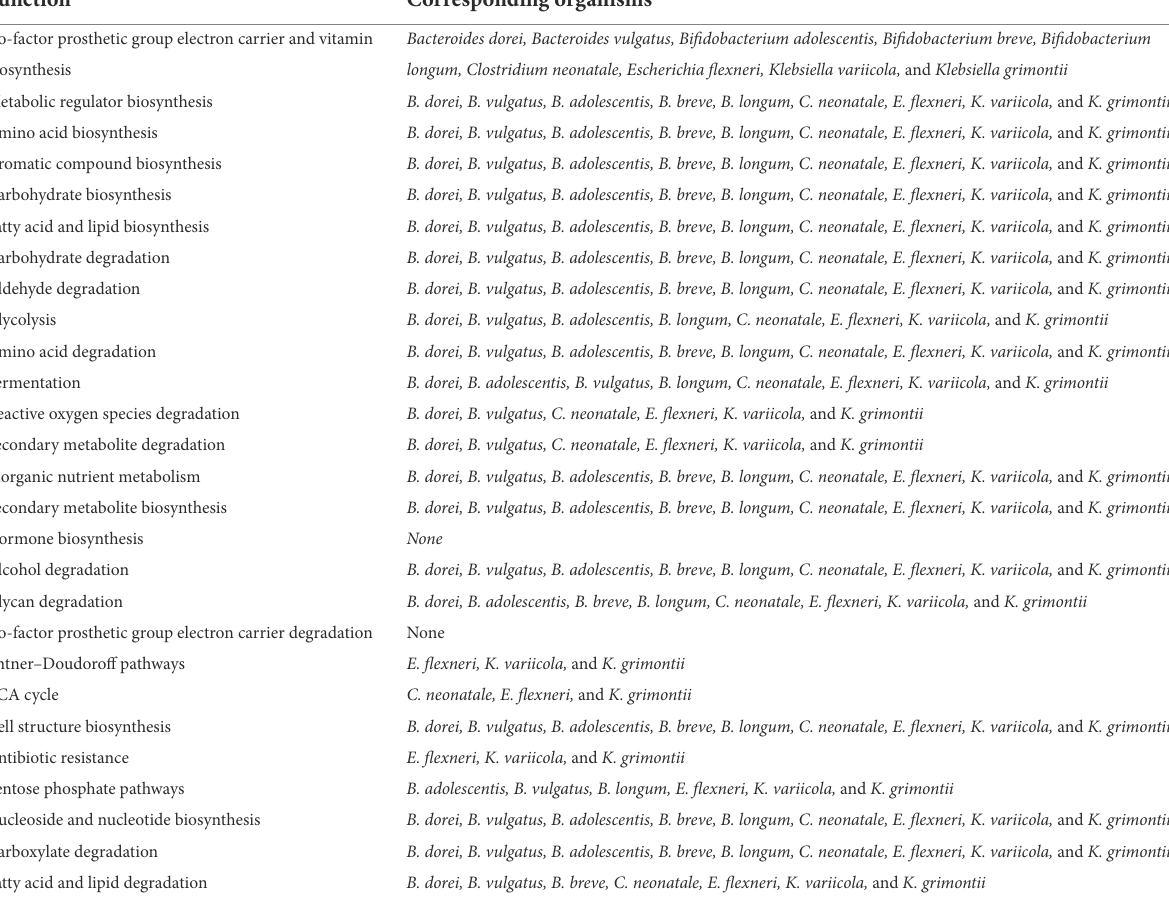
TABLE 5 Significantly different bacterial metabolic pathways identified in infant stool samples pre- and post-dietary intervention and the corresponding organisms that potentially account for the functional changes.